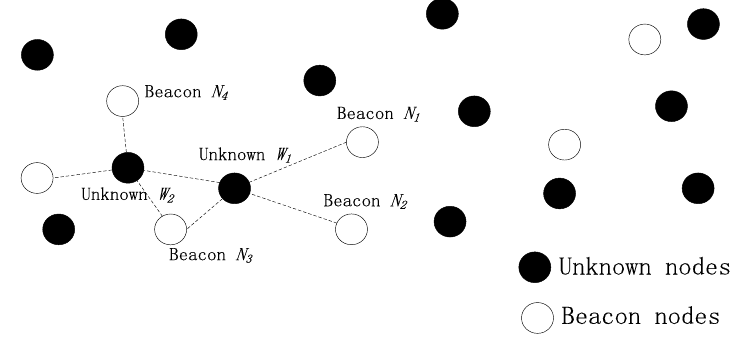
Figure 5. The calculation of unknown nodes' velocity.